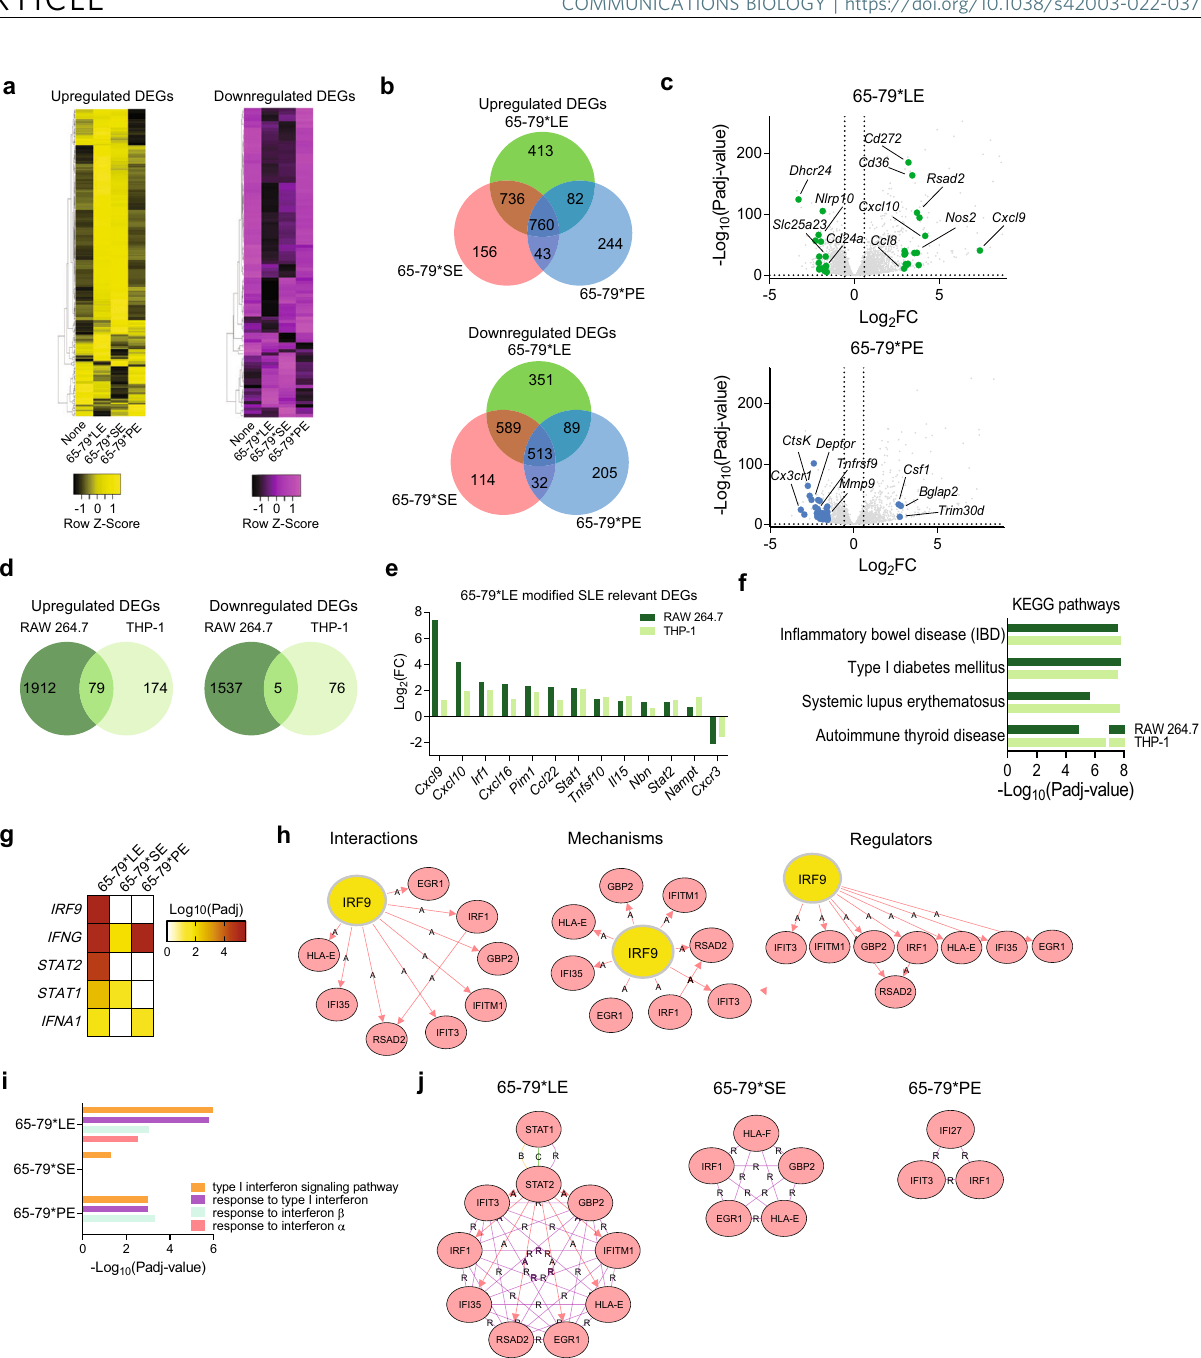
Fig. 2 Transcriptional modulation by the LE (Model B: epitope + IFN- γ , versus epitope alone). a Heatmaps showing unsupervised clustering of upregulated (left, yellow) and downregulated (right, purple) DEGs for 65-79*LE, 65-79*SE and 65-79*PE. DEGs were selected based on a >3-fold change for 65-79*LE. All depicted DEGs had a P adj < 0.05. b Venn diagram comparing DEGs for 65-79*LE, 65-79*SE and 65-79*PE. c Volcano plots comparing the differential transcriptional modulation by 65-79*LE and 65-79*PE. Green dots denote SLE-relevant genes modulated by 65-79*LE; blue dots denote RA- relevant genes modulated by 65-79*PE. d Venn diagrams illustrating the overlap between 65-79*LE-modulated gene expression in RAW 264.7 and THP-1 macrophages. e Representative SLE-relevant genes modulated by 65-79*LE in RAW 264.7 and THP-1 macrophages. f Notable KEGG disease pathway enrichment among 65-79*LE-upregulated DEGs in RAW 264.7 and THP-1 macrophages. g Heatmap of top-ranked URs that are predicted to be activated in 65-79*LE- versus 65-79*SE- and 65-79*PE-modulated transcriptomes in THP-1 macrophages. h Regulatory networks showing the interactions, mechanisms, and regulator modes for IRF9 in THP-1 macrophages. i , IFN-I-related GO-BP terms in 65-79*LE-, versus 65-79*SE- or 65-79*PE-activated transcriptomes in THP-1 macrophages. j Comparative hub gene networks for the GO-BP term “ type I interferon signaling pathway ” in 65-79*LE-, versus 65- 79*SE- or 65-79*PE-activated transcriptomes in THP-1 macrophages. Data are based on DEGs with fold change >1.5 and P adj < 0.05. All RAW 264.7 macrophage data are based on 6 biological replicates in 2 independent experiments. THP-1 macrophage data are based on 4 biological replicates. See also Supplementary Fig. 2 and Supplementary Tables 2 –